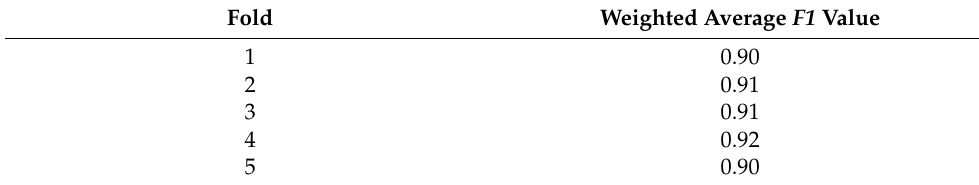
Figure 11. The confusion matrix of 5-fold cross validation: ( a ) fold 1; ( b ) fold 2; ( c ) fold 3; ( d ) fold 4; ( e ) fold 5. Table 7. The results of 5-fold cross